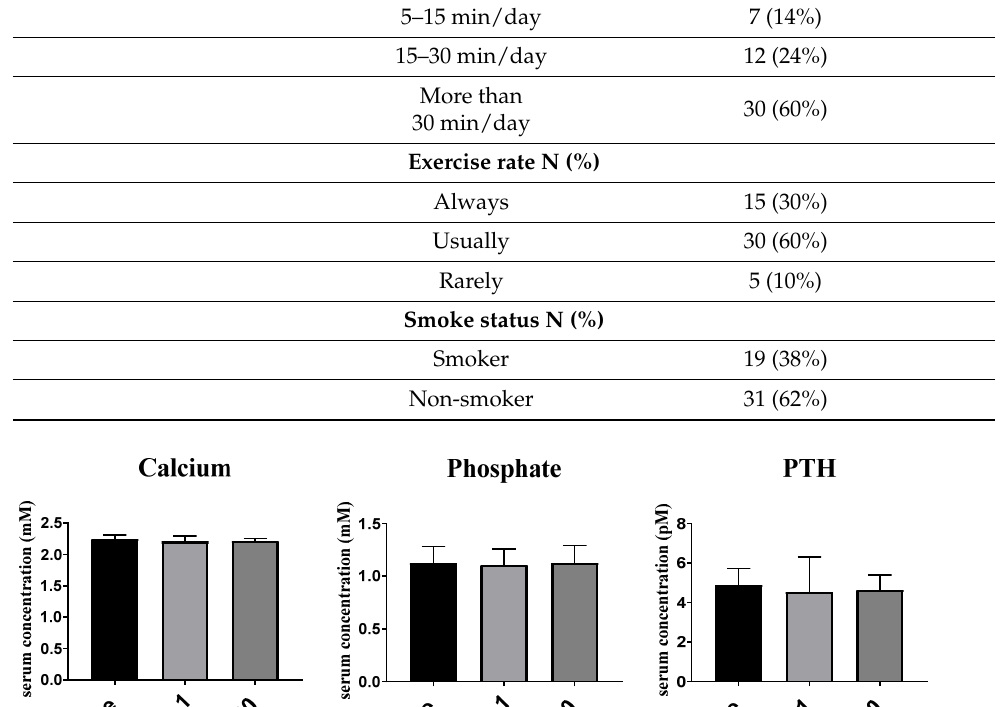
Figure 1. Serum concentration of Ca 2+ , PO 4 − and PTH. The median serum concentrations were compared between days 0, 1 and 30 of vitamin D 3 supplementation. The error bars represent interquartile range. Data were analyzed by non-parametric repeated measure ANOVA followed by Wilcoxon signed-rank multiple comparison test.